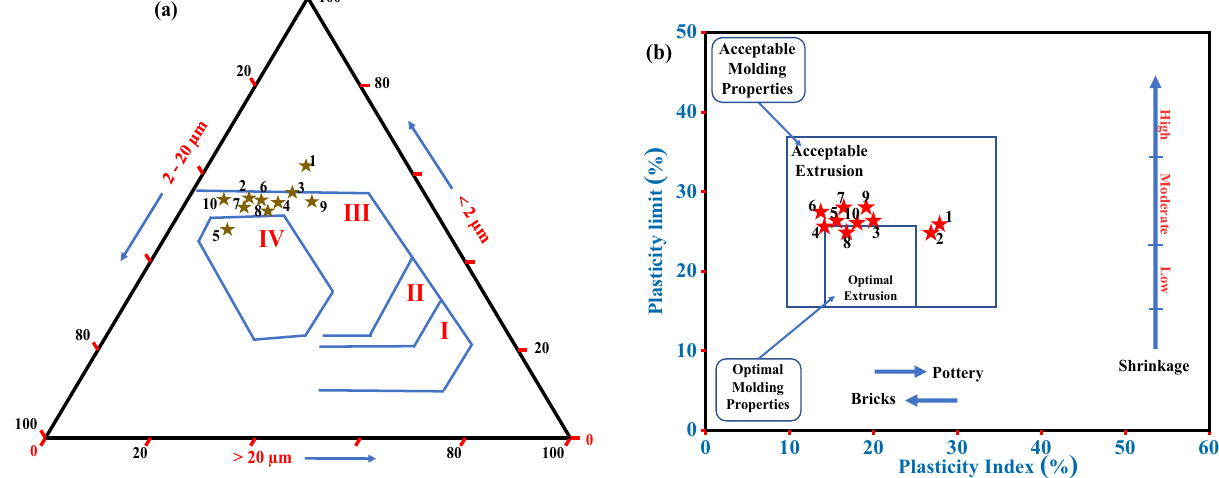
Figure 8. Shows: ( a ) Grain size classification of the clay-rich materials according to Winkler’s scheme (after Winkler (1954) and Nyakairu et al. (2002) 78,79 ); Fields are defined as: (I) common bricks, (II) vertically perforated bricks, (III) roofing tiles and masonry bricks, and (IV) hollow products, and ( b ) Molding prognostic through the Atterberg limits (workability chart) (after Bain and Highley (1979) and Hosni et al. (2021) 72,80